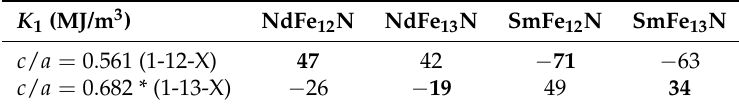
Table 3. Anisotropy constant K 1 for a selection of compounds where the c / a ratio was either the one of crystal structure in the c-direction, as shown in Figure 1, is considered. The corresponding c/a value of 0.682 is one half of c / a =